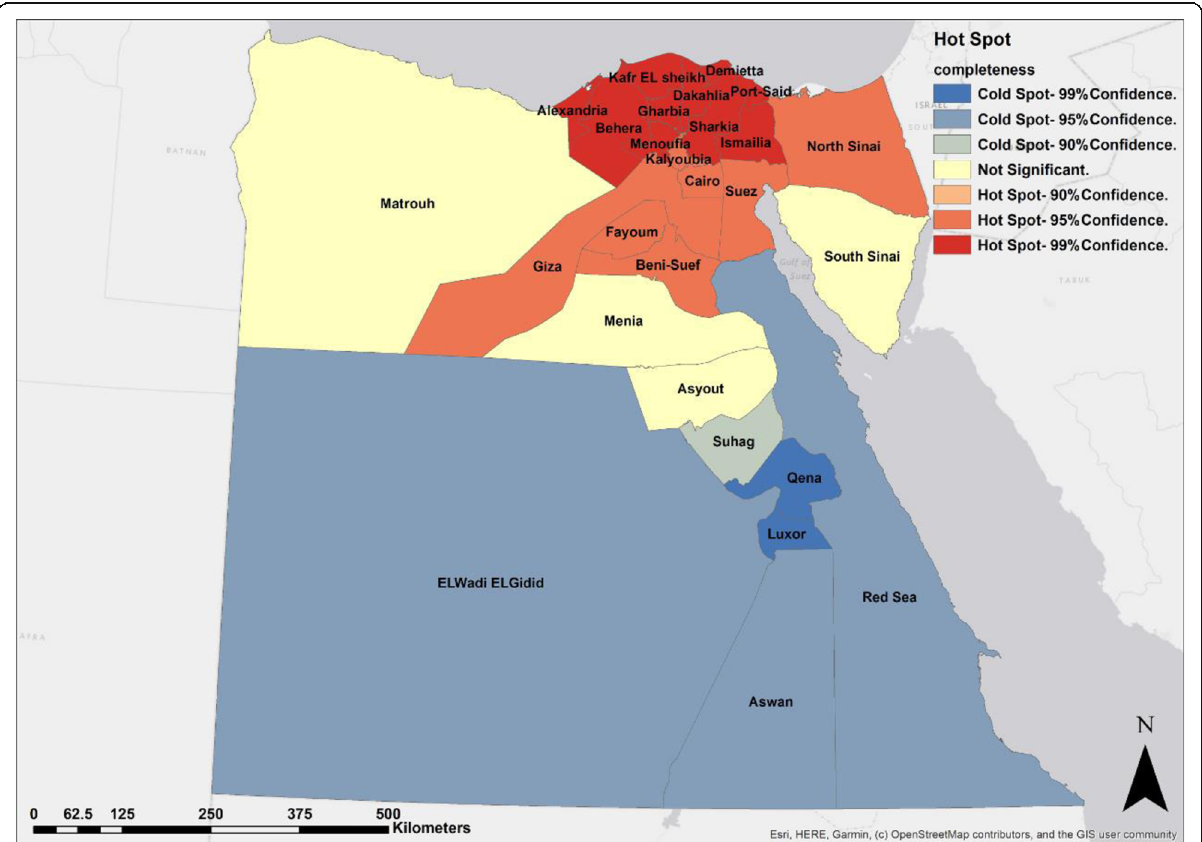
Fig. 2 Hot spots of the completeness of death registration, Egypt,